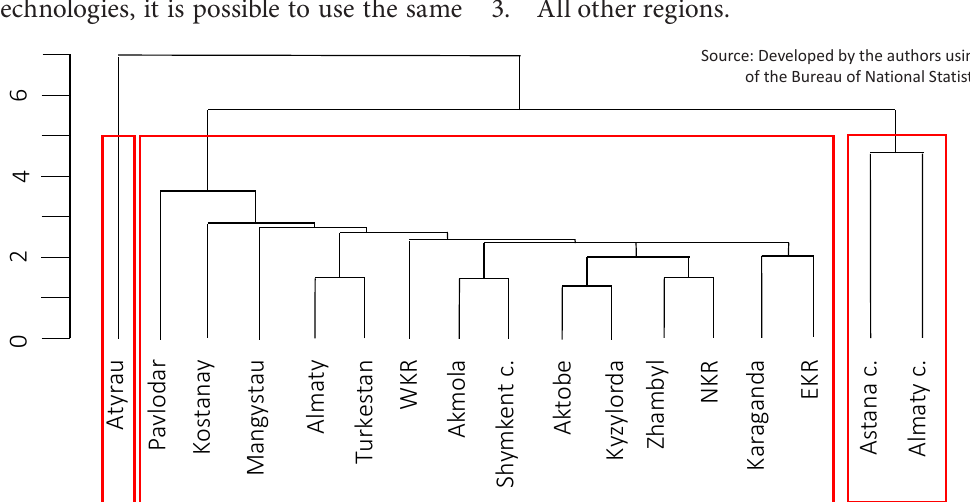
Figure 1. Dendrogram of clusters of regions of Kazakhstan, single